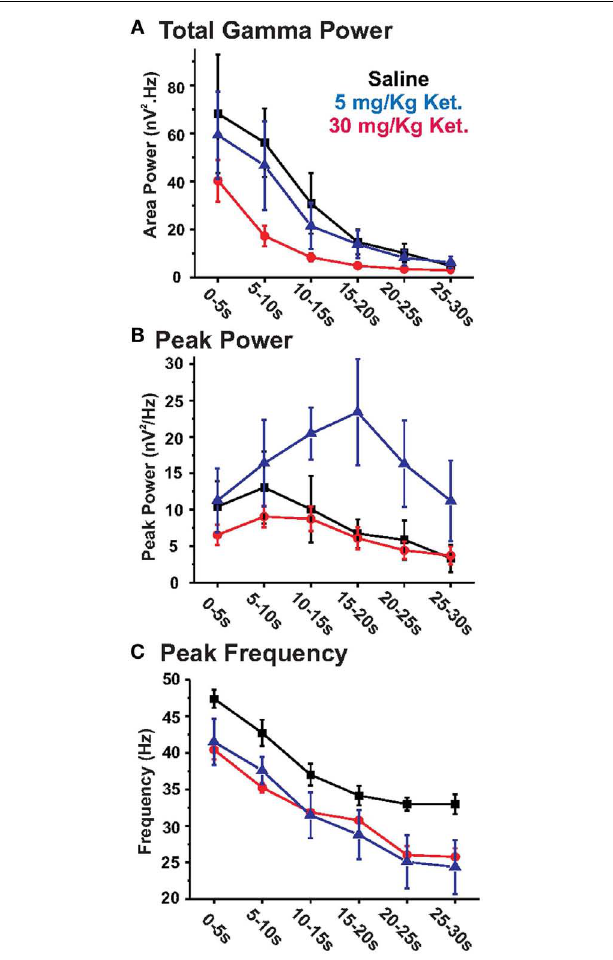
FIGURE 3 | Chronic MK-801 treatment does not significantly alter KA-elicited PrL oscillations . Graphs show the effects of chronic MK-801 given at daily doses of 0.02mg/kg (blue) or 2mg/kg (red) on (A) total GBO power (40–50Hz), (B) peak power, and (C) peak frequency across 30s of the elicited oscillatory response recorded from acute PrL slices, compared to saline treated controls (black). At both concentrations chronic MK-801 treatment resulted in no significant alteration of KA-elicited oscillatory activity. p < 0.05), and fourth (15–20 s; t 13 = 2.30, p < 0.05) epochs.